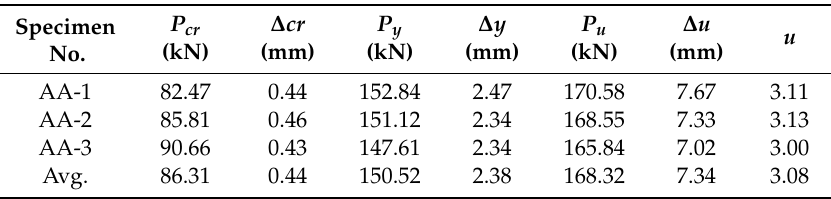
Table 1. Load bearing and